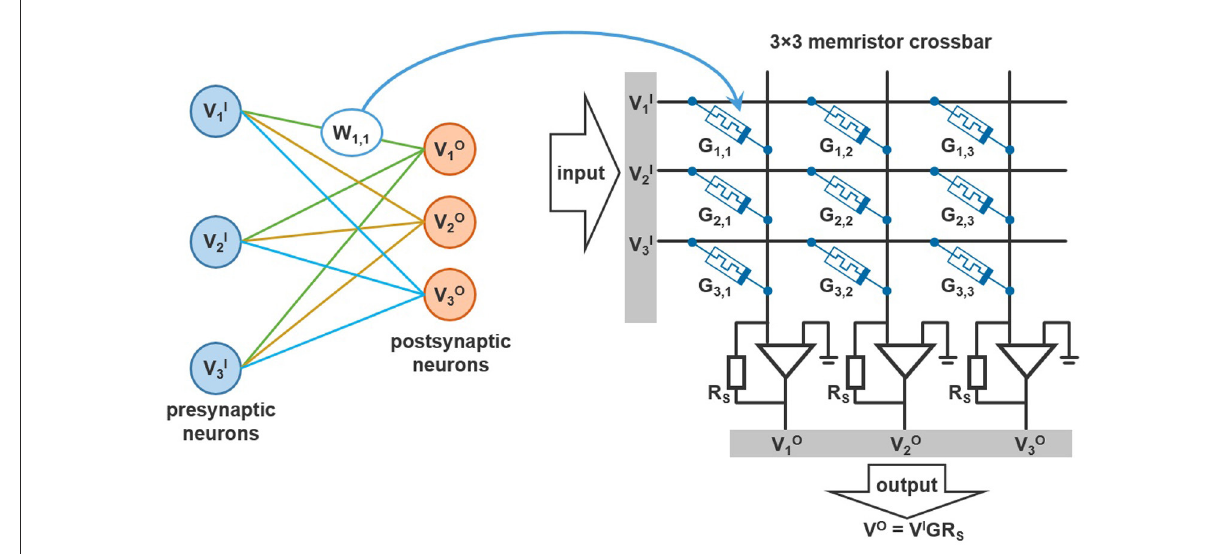
FIGURE4 Typical 3 × 3 memristor crossbar used in neuromorphic applications.